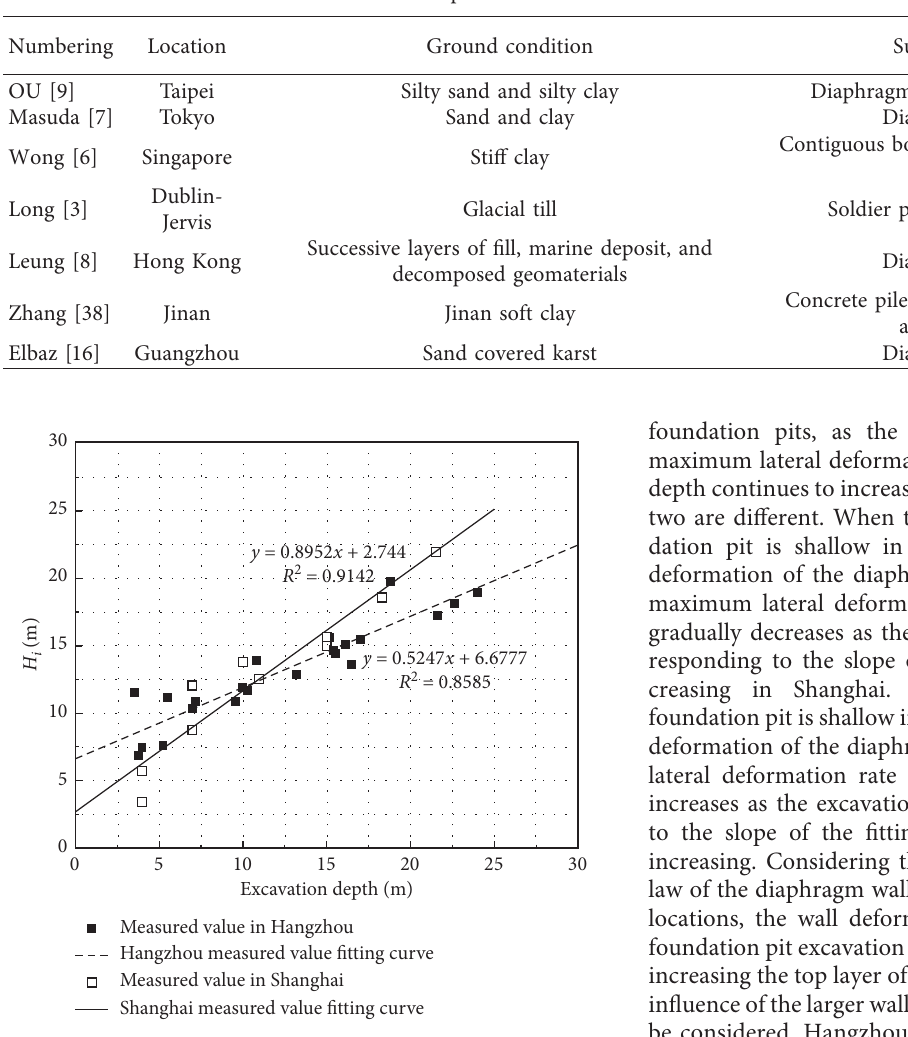
Table 3: Comparison of wall lateral deformation with other areas.